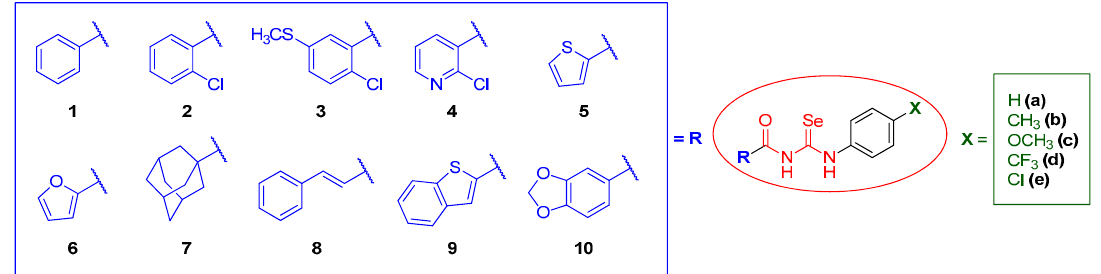
Figure 2. Structural design of the acylselenoureas presented in this work.